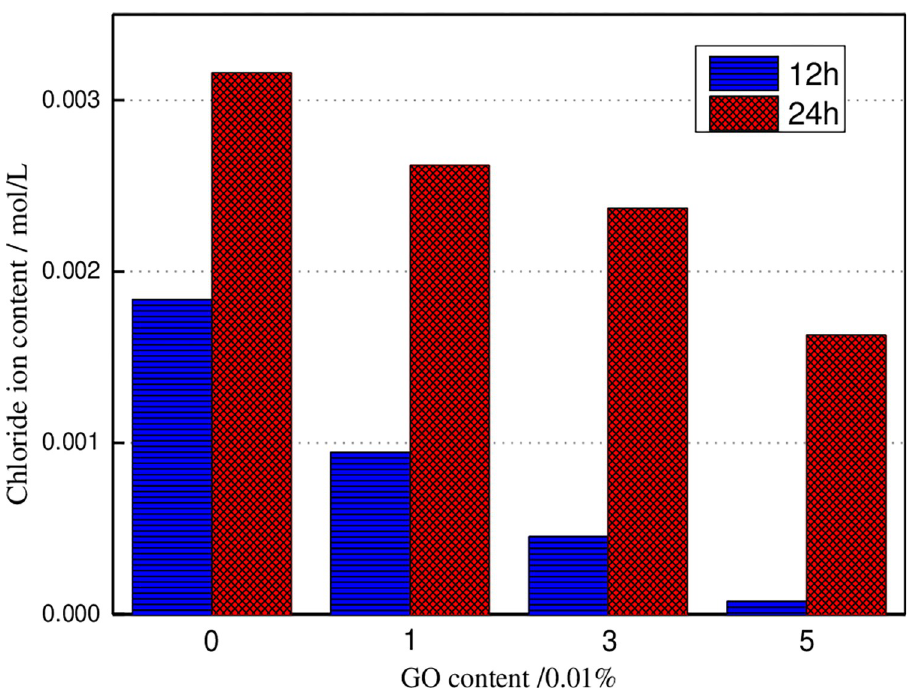
Fig 7. The chloride content in concrete specimens under the various applied current